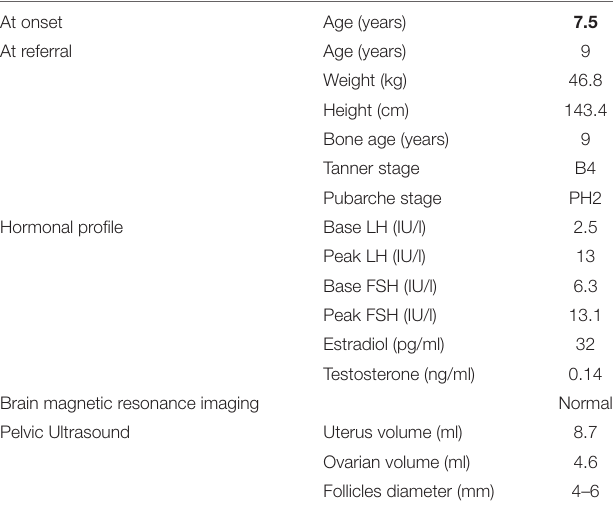
TABLE 1 | Clinical and laboratory characteristics of the proband with MKRN3 mutation. At